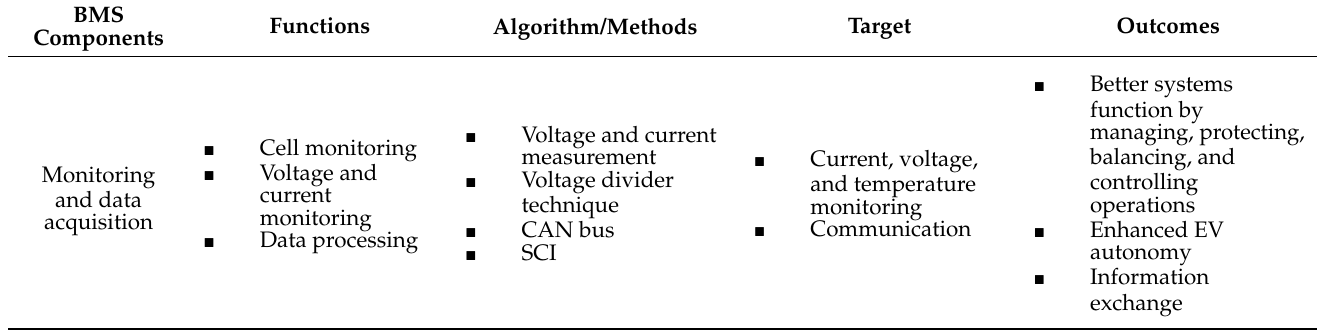
Table 1. The various BMS components, functions, algorithms, targets, and outcomes in EV applications. BMS Functions Algorithm/Methods Target Components